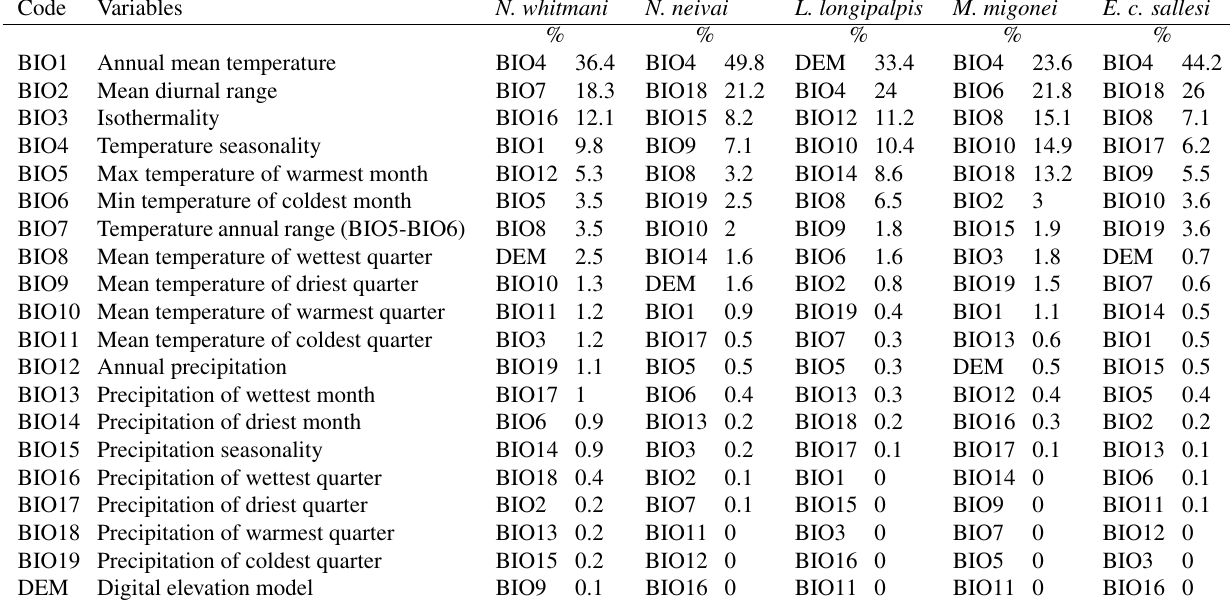
Table 1. Relative contributions of the environmental variables to the Maxent models of Nyssomyia whitmani , Nyssomyia neivai